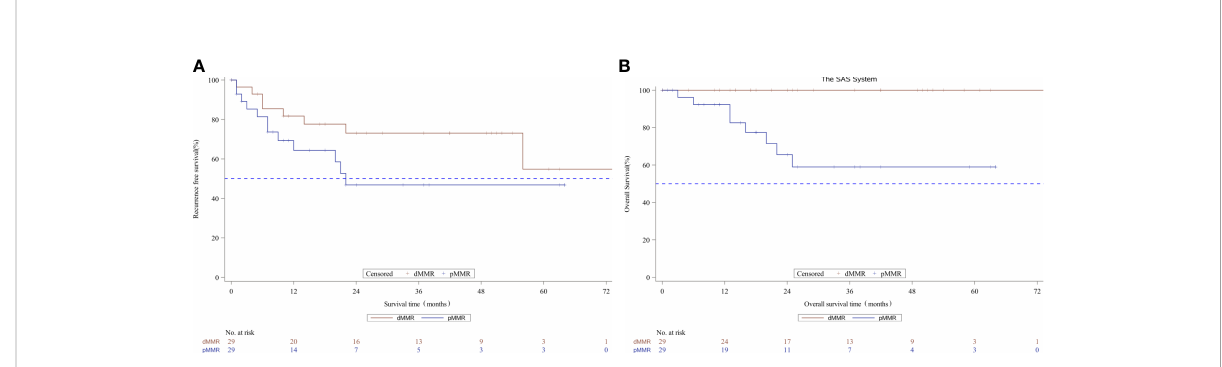
FIGURE 2 Kaplan-Meier curves for recurrence-free survival (A) and overall survival (B) according to MMR status in the propensity score matched subset patients. MMR denotes mismatch repair, dMMRdefective MMR; pMMRpro fi